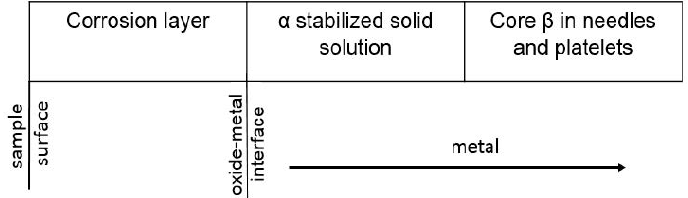
Figure 11. Schematic representation of the structural constituents on the sample section in relation to the oxide–metal surface and